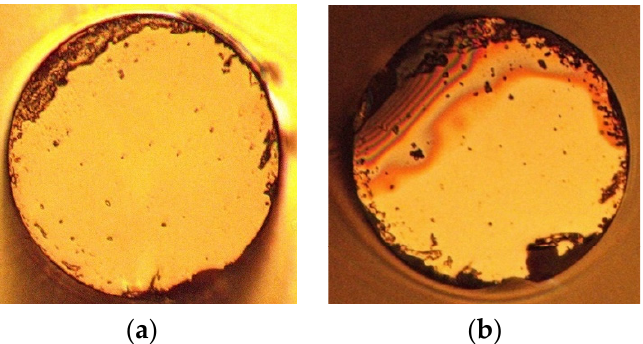
Figure 15. End face of the fiber with gold film under a microscope ( a ) Gold film before high-temperature annealing; ( b ) Gold film after high-temperature annealing.